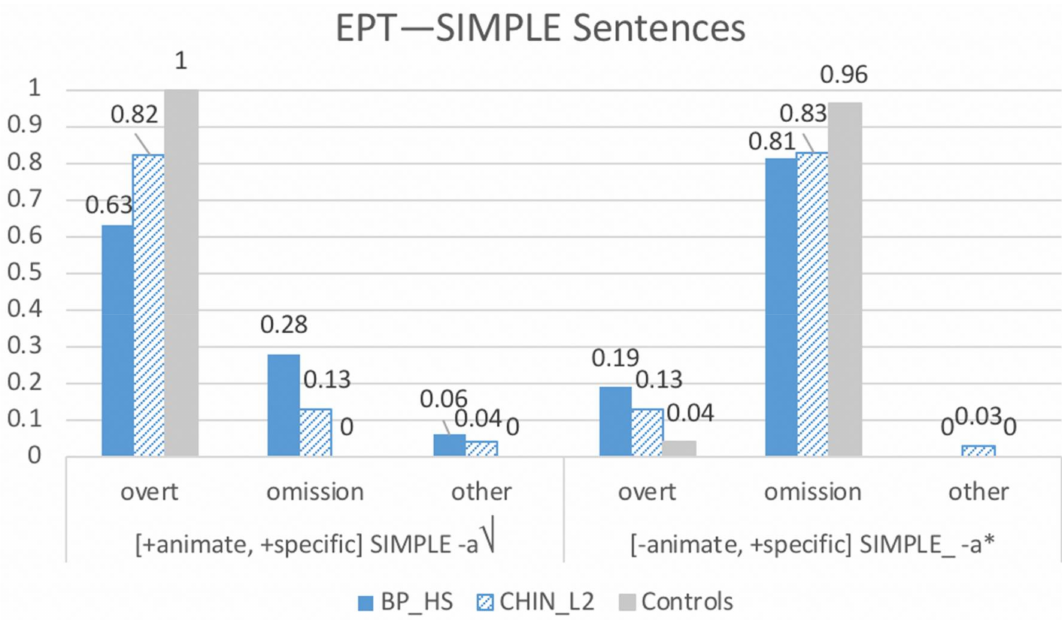
Figure 1. Elicited production task (EPT): proportion of Differential Object Marking (DOM) use, omission and other structures realized per group in simple sentences. BP_HS: Brazilian Portuguese Heritage Speakers; CHIN_L2: Chinese L2